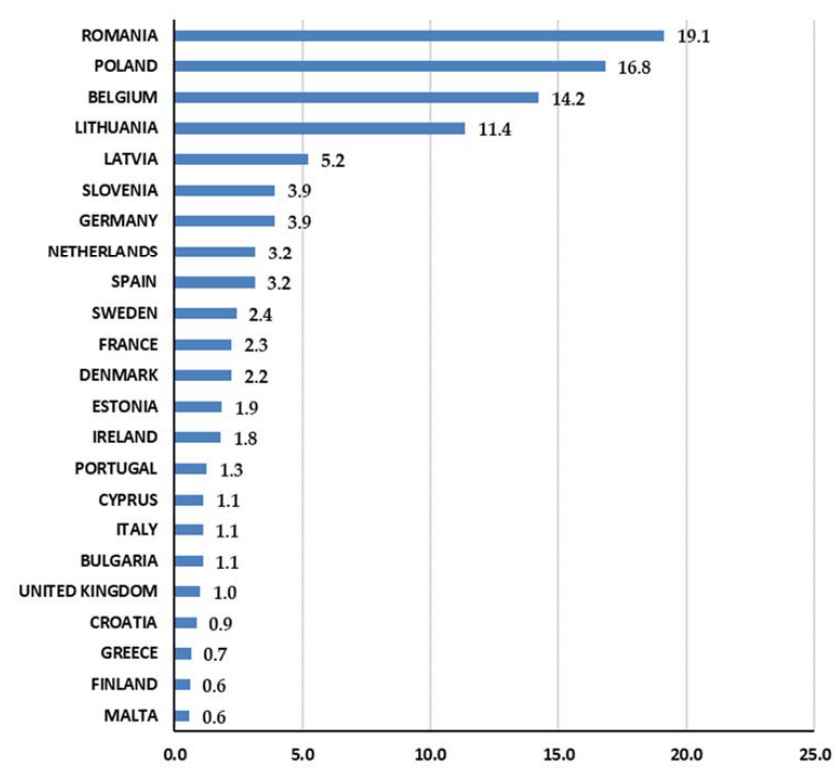
Figure 5. Percentage distribution of the FEMP among the fleet for the period 2014–2020. Source: Own elaboration based on data published by the European Commission and Eurostat. https://ec.europa.eu/oceans-and-fisheries/funding/european-maritime-and-fisheries-fund-emff_es (accessed on 11 January 2022).